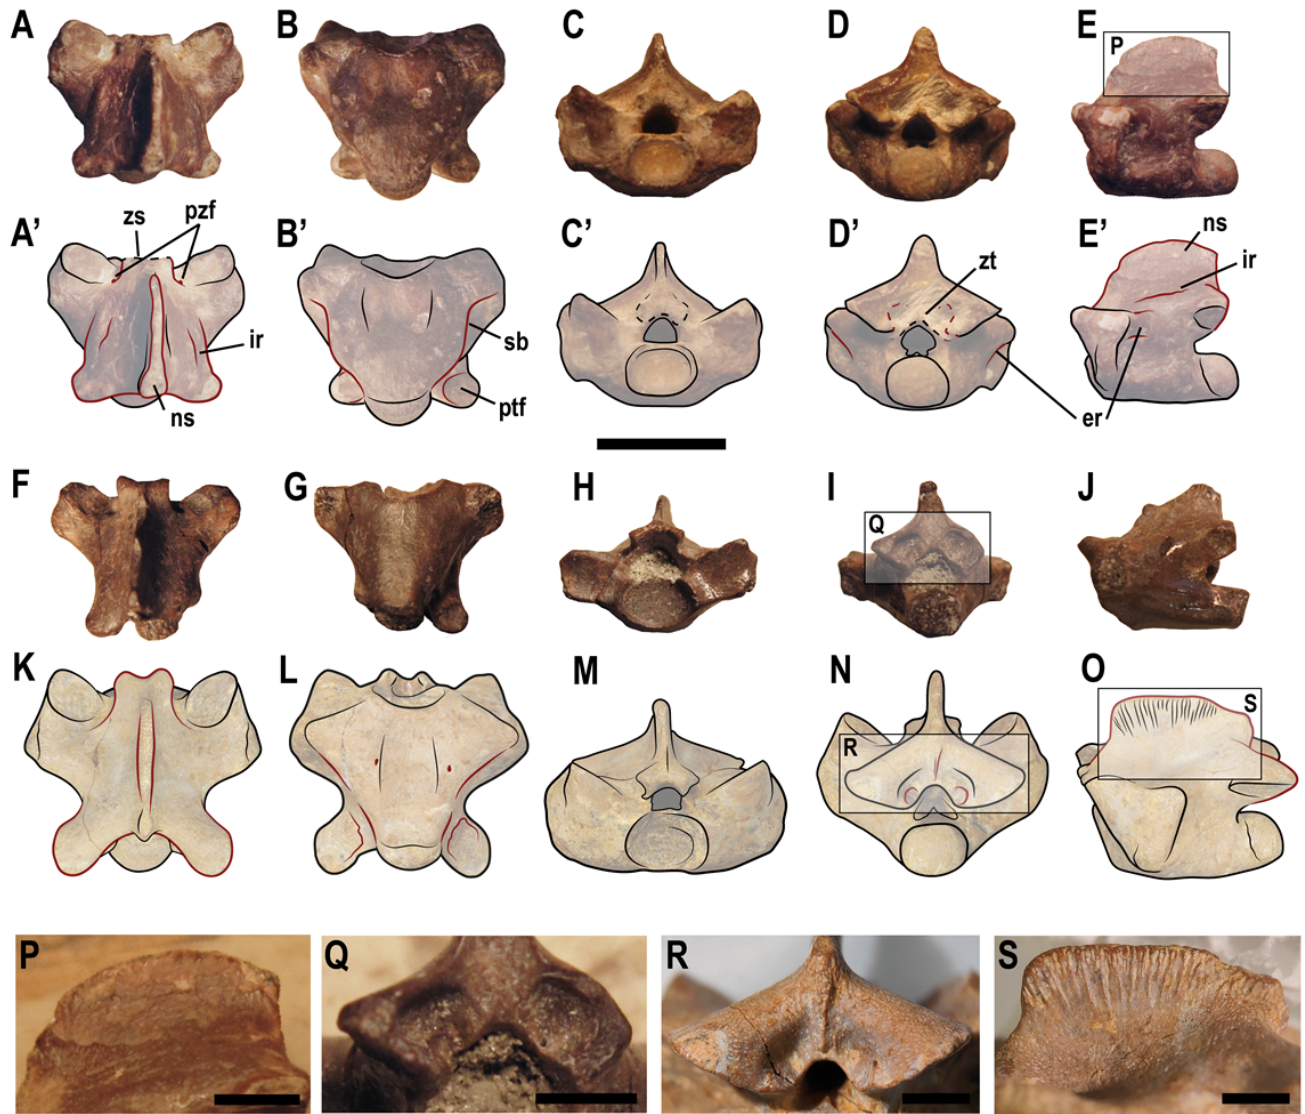
Figure 5. Comparison of vertebral characters in Carentonosaurus mineaui ( A – J , P – Q ) and Carentono- saurus algorensis sp. nov. ( K – O , R – S ). The red lines indicate characters discussed in the text that di ff er between Carentonosaurus mineaui , here represented by the holotype (MNHN IMD 21) ( A – E , P ) and a posterior-most cervical vertebra from the type locality (MNHN IMD 40) ( F – J , Q ), and Carentono- saurus algorensis sp. nov. (represented by its holotype, ALG 200) ( K – O , R – S ). Scale bars: 10 mm ( A – O ) and 3 mm ( P – S ).